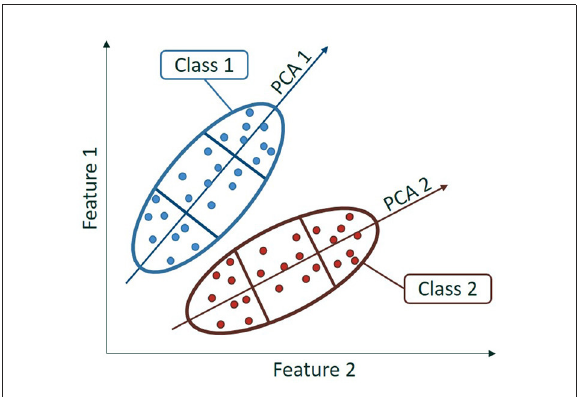
FIGURE2 Schematic of a two-class dataset using the first dimension of a PCA for each class.